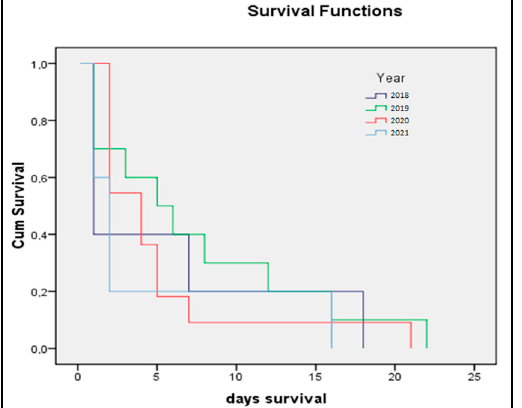
Figure 5. Kaplan–Meier plot of preterm newborn survival (in days)—4-year comparison.